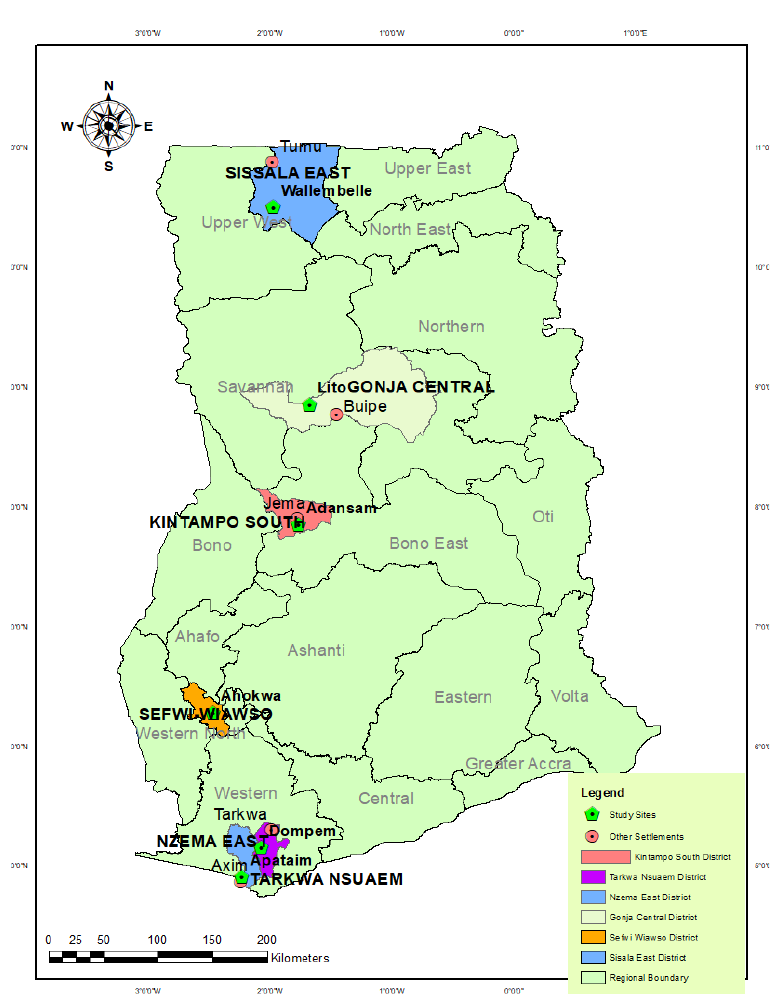
Figure 1. Location of the reconnaissance survey and the two main study